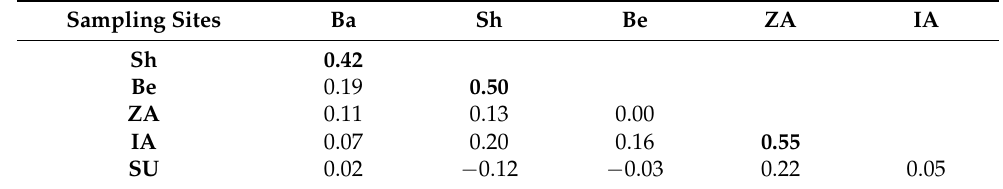
Table 3. Correlation coefficients between local standard tree-ring width chronologies, calculated over respective overlap periods after cut-off by criterion EPS > 0.85 (Ba—Bayanaul,